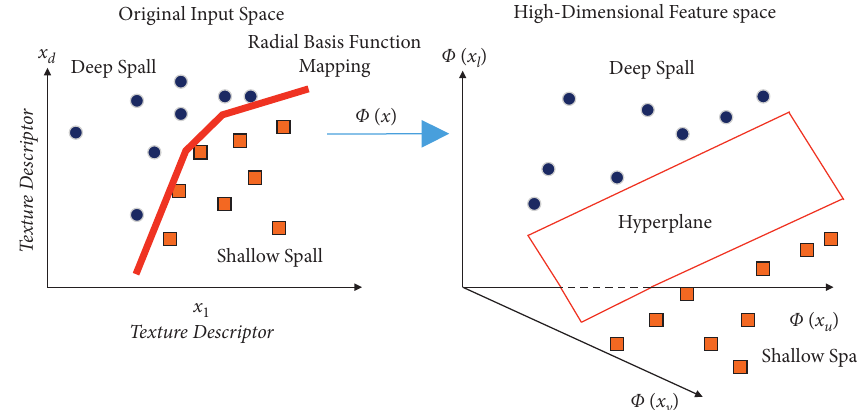
Figure 4: Demonstration of the SVC-based spalling severity